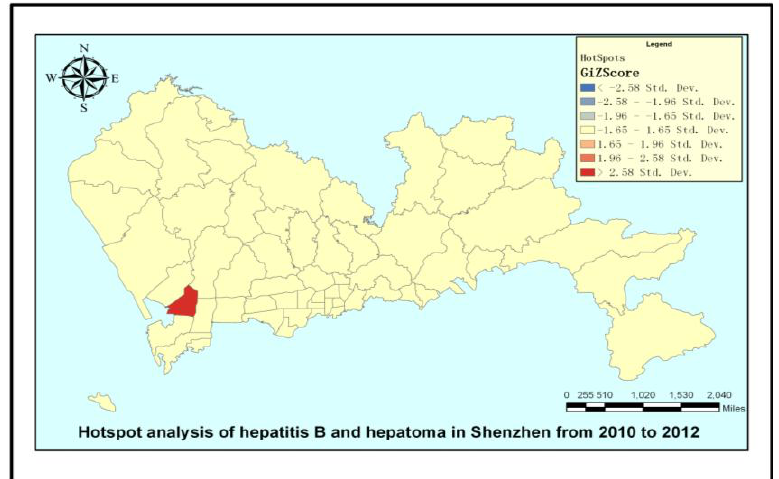
Figure 3. Hotspot analysis of hepatitis B and hepatoma in Shenzhen.